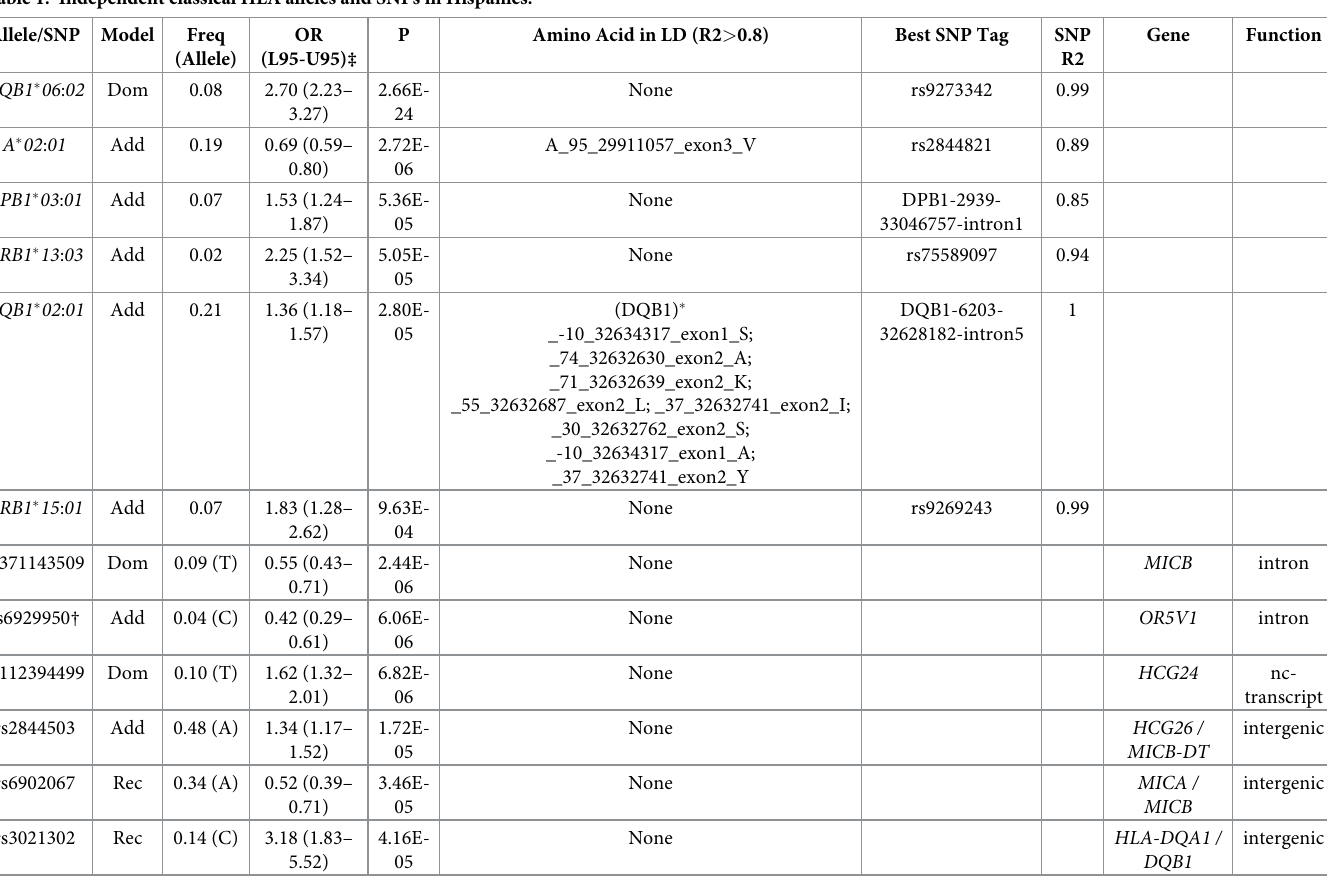
Table 1. Independent classical HLA alleles and SNPs in Hispanics. Allele/SNP